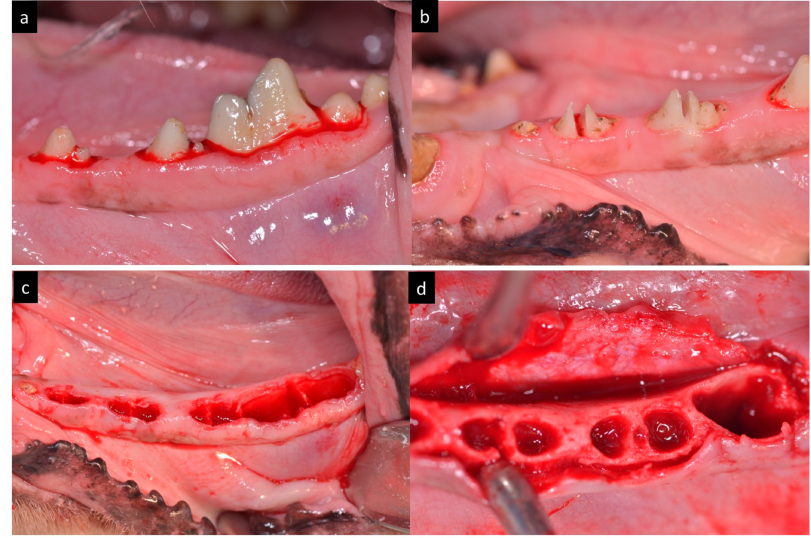
Figure 1. ( a ) Preoperative aspect of the teeth. ( b ) Teeth sectioned in bucco-lingual direction. ( c ) Post extraction sockets. ( d ) Full-thickness